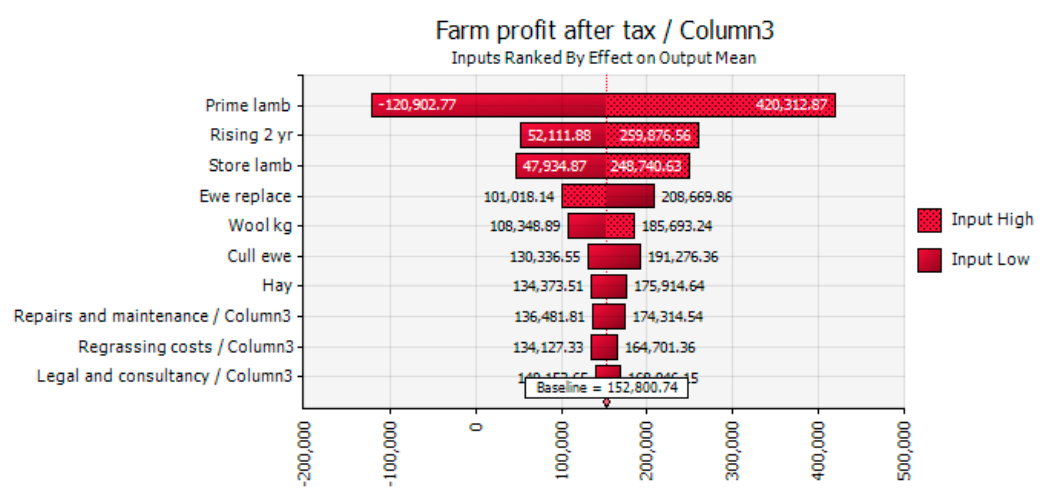
Figure 6. Simulated risk profile with 5000 iterations when 50% rather than 15% of lambs are sold as prime.